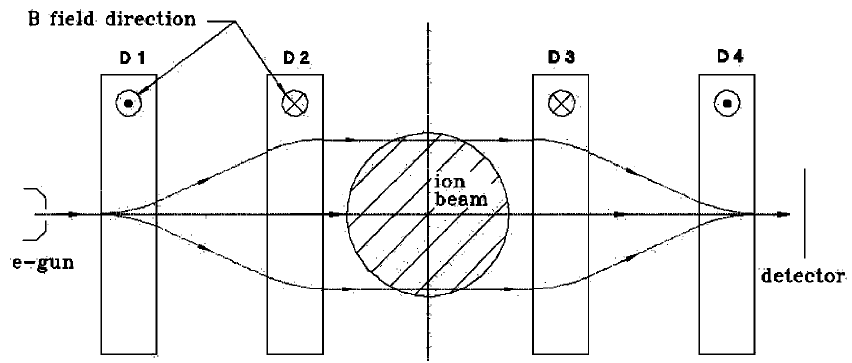
FIG. 8. Sketch of the NTX nonintercepting beam